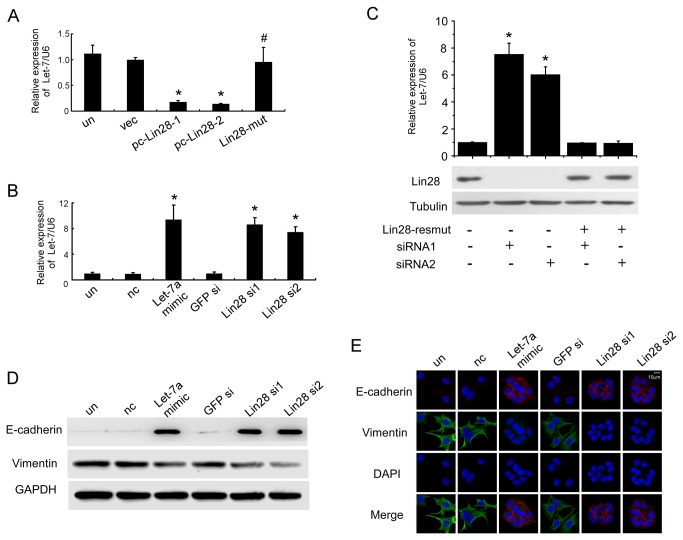
Lin28 induces EMT by inhibiting let-7a expression.The expression of let-7a, normalized to U6, was decreased in pc-Lin28-1 and pc-Lin28-2 MCF-7 cells when compared to empty vector and Lin28-mut transfectants (A), and the levels of let-7a were restored by transfection of let-7a mimics or Lin28-siRNA in pc-Lin28-1 (B). (C) Quantitative RT-PCR to assess Let-7a expression in pc-Lin28-1 cells cotransfected with Lin28-resmut and Lin28 siRNAs using Lipofectamine 2000. U6 was used as a loading control. Western blotting (D) and Immunoﬂuorescence staining (E) illustrated increased expression of E-cadherin and reduced expression of vimentin in pc-Lin28-1 cells that had been transfected with let-7a mimics and Lin28-siRNA. E-cadherin: red, vimentin: green, cell nuclei: blue. Bar, 10 μm.